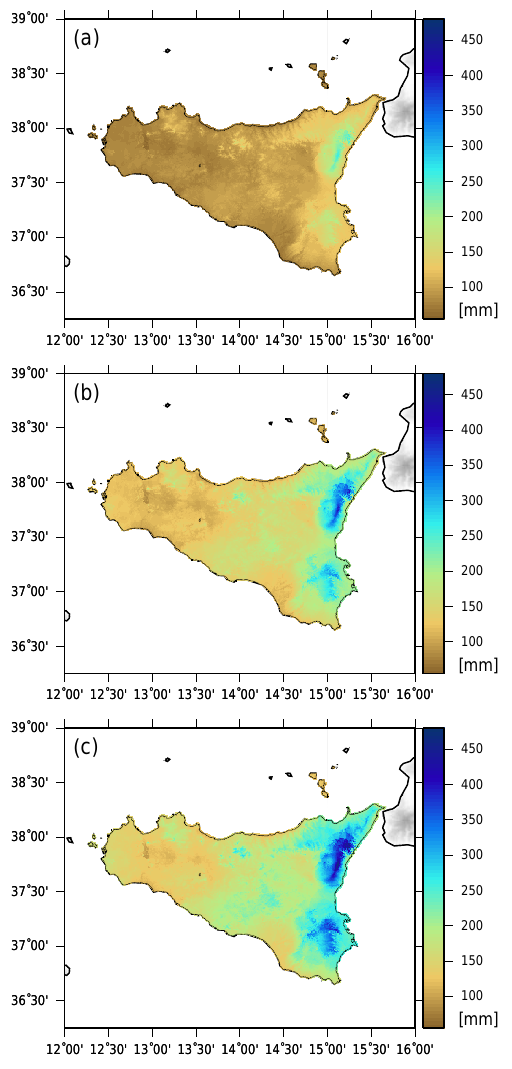
Figure 10. (a, b, c) Grid-point RL10, RL50 and RL100, respec- tively, expressed as absolute precipitation amounts